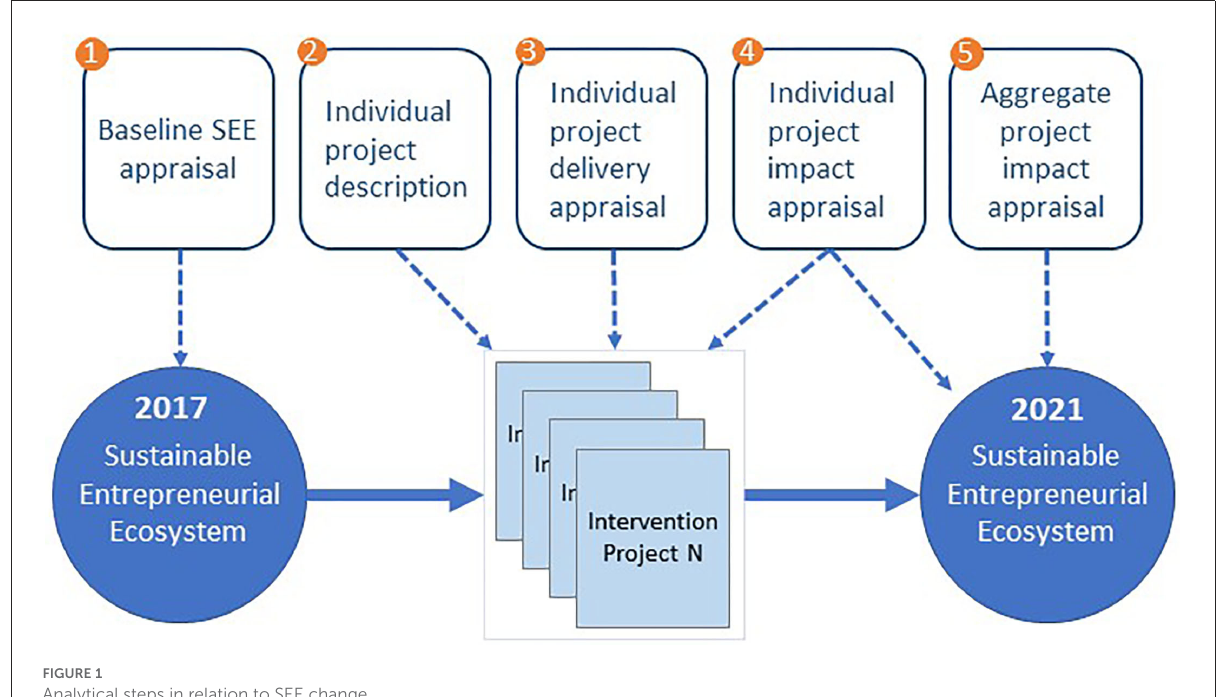
FIGURE1 Analytical steps in relation to SEE change.